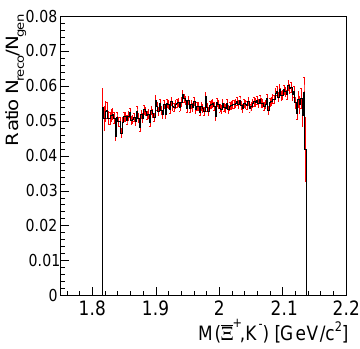
Figure 6. Ratio of the generated and the MC truth partner of the + reconstructed Ξ K − mass distribution. Adapted from [12].